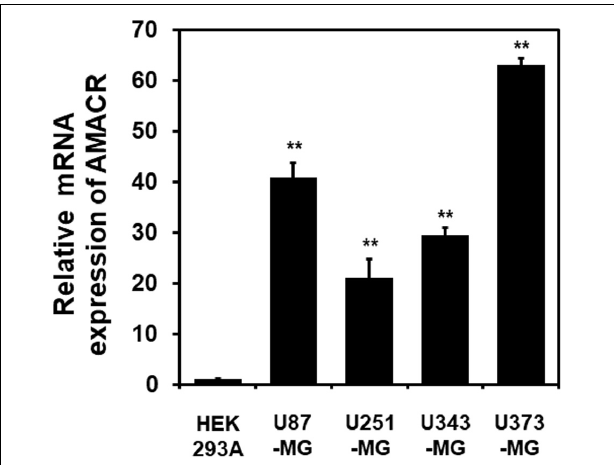
FIGURE 5 | Elevation of AMACR mRNA levels in human glioblastoma cell lines. Total RNA from each glioblastoma cell line was extracted and analyzed using human AMACR specific primers by real-time quantitative polymerase chain reaction (qPCR). The results are presented as the means ± SD obtained from three independent experiments. Expression of AMACR mRNA was greatly increased in all glioblastoma cell lines. *, p < 0.05 [adapted from Lee (2019)].